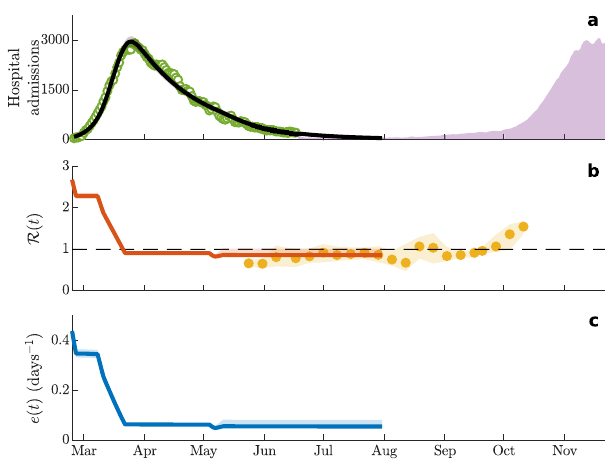
Fig. 6 Effective reproduction number R ð t Þ and epidemicity index e ( t ) for the fi rst wave of the COVID-19 pandemic in Italy. a Hospital admissions (March to November 2020). Green empty dots represent the curated data that has been used 14 to calibrate the SEPIAR model (the black line and black shading are the median and the 95% con fi dence interval, respectively, of 2000 simulations with parameter values drawn from a posterior distribution estimated from data). The SEPIAR model has been run until the end of July for validation. Purple shading shows data not used for calibration. b Temporal dynamics of the effective reproduction number obtained from SEPIAR (red curve: median; red shading: 95% con fi dence interval). Also shown (yellow dots) is the timeseries of effective reproduction numbers and their con fi dence interval (yellow shading) as published by ISS 51 . c Effective epidemicity index (blue curve: median; blue shading: 95% con fi dence interval) computed from SEPIAR ( “ Methods ”